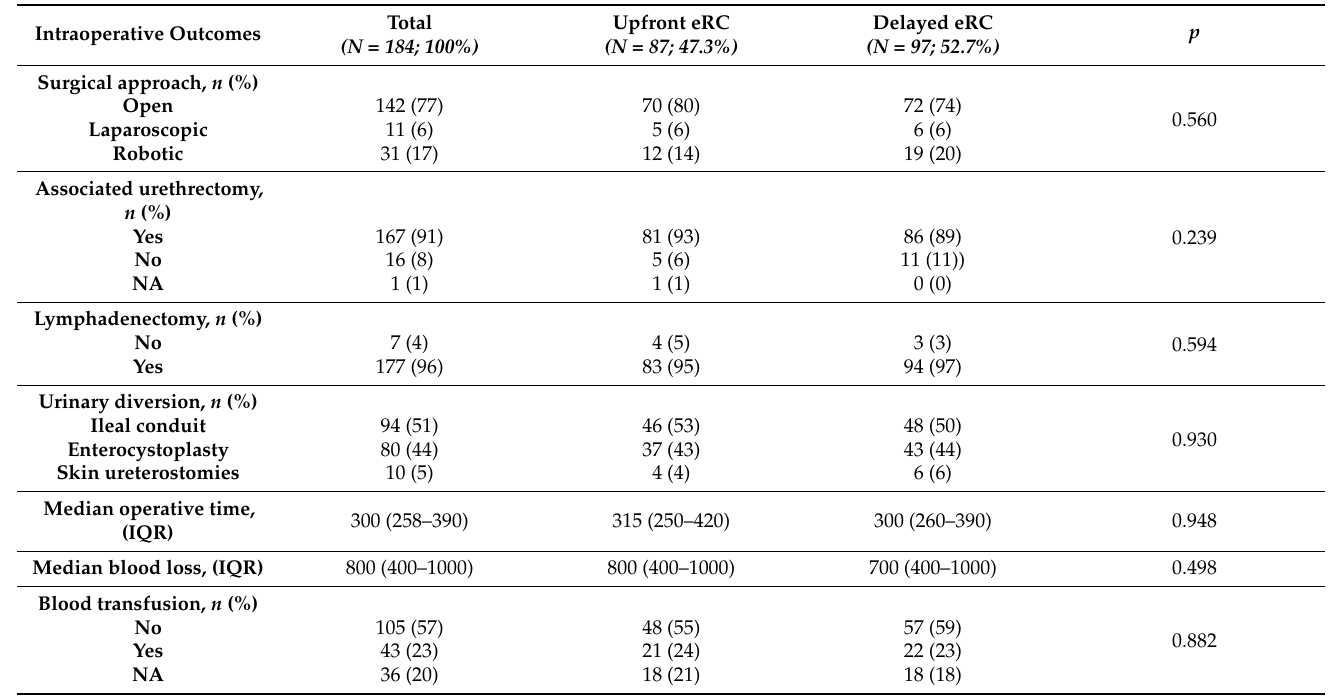
Table 2. Intraoperative outcomes of included patients treated with upfront or delayed eRC for HR-NMIBC.